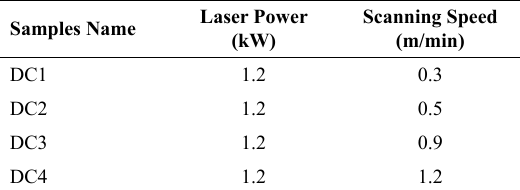
Table 1. Experimental